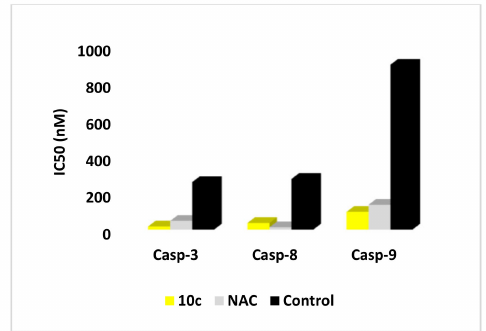
Figure 8. IC 50 (nM) of compounds 6c and NAC on the active caspases-3, 8, and